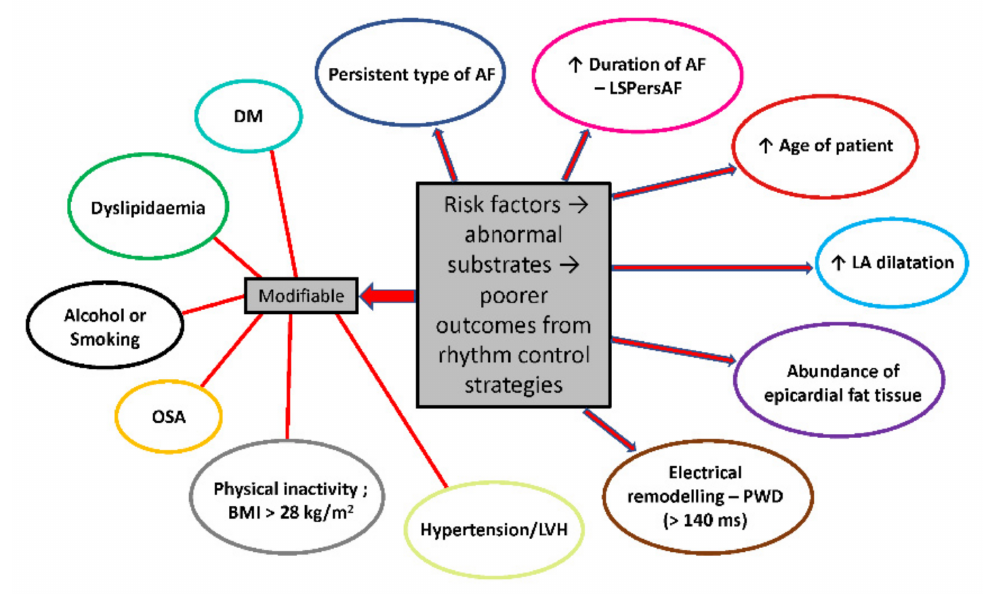
Figure 1. Risk factors for perpetuation of AF. Modifiable risk factors are highlighted separately. LSPersAF, long-standing persistent AF; LA, left atrium; PWD, p-wave duration; LVH, left ventricular hypertrophy; BMI, body mass index; OSA, obstructive sleep apnoea; DM, diabetes